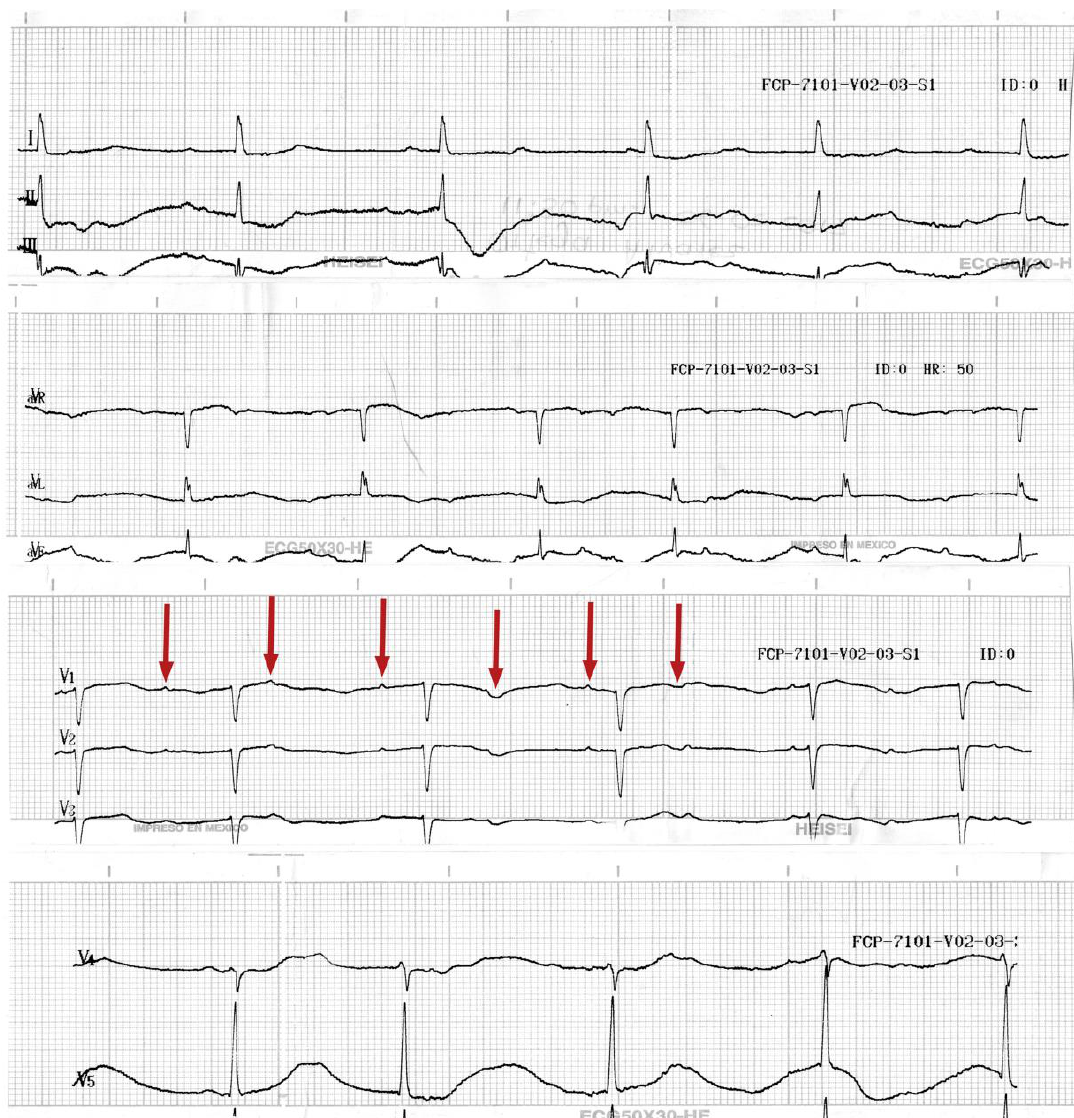
Figure 1. Electrocardiogram of the patient on admission to the emergency room. It shows a dissociation of P waves (V 1 Red arrows) from the QRS complexes.